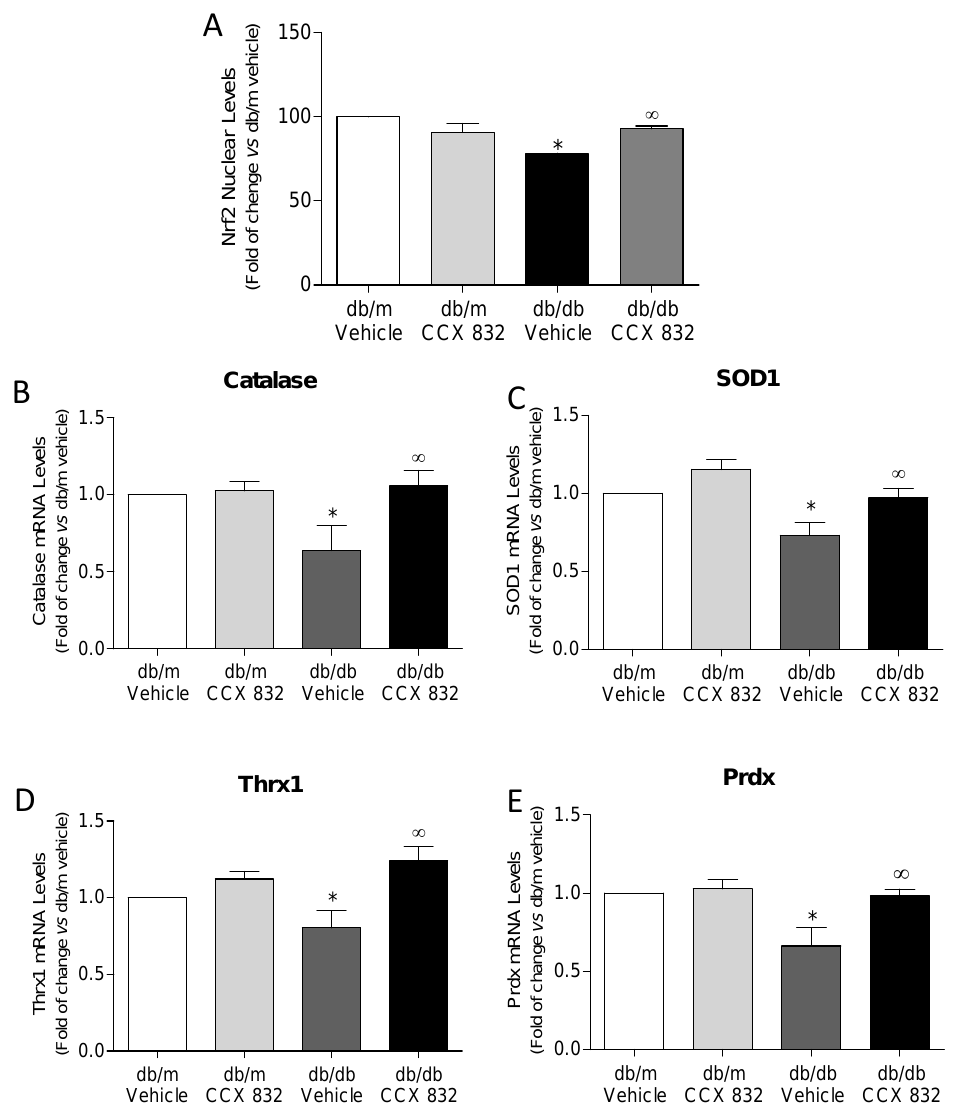
Figure 4. ChemR23 antagonism attenuates impaired Nrf2 nuclear translocation and increases antioxidant enzymes expression in kidneys from db/db mice. ( A ) Nuclear accumulation of Nrf2 was determined by ELISA in nuclear extract of kidneys from vehicle and CCX832-treated db/m and db/db mice. ( B – E ) mRNA expression of genes regulated by Nrf2 was determined by real time PCR. The values were normalized by total protein levels ( A ) or by GAPDH mRNA expression ( B – E ). Results represent the mean ± SEM of 5 to 8 experiments. * p < 0.05 vs. db/m, ∞ p < 0.05 vs. db/db vehicle .